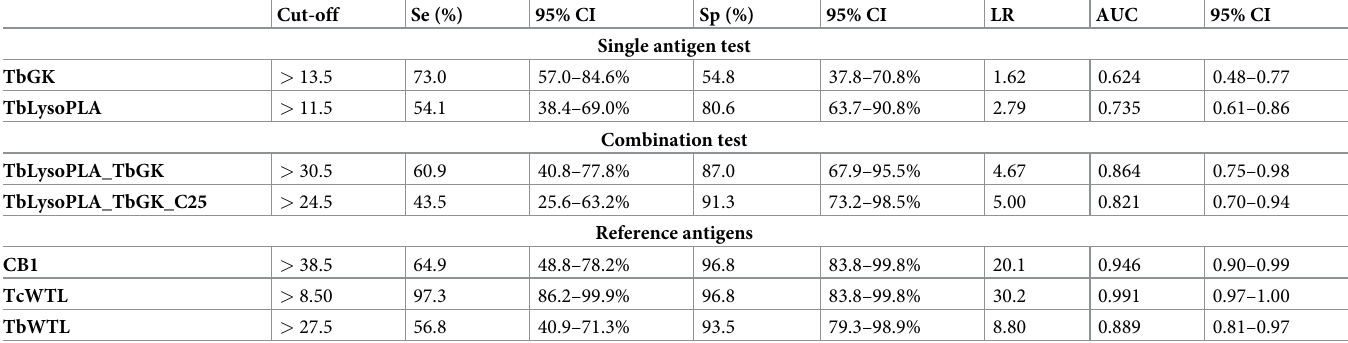
Table 4. Diagnostic performance parameters determined by ROC analysis of single antigen and mixture testings using sera of T . congolense experimentally infected cattle in ELISA. Cut-off Se (%) 95%